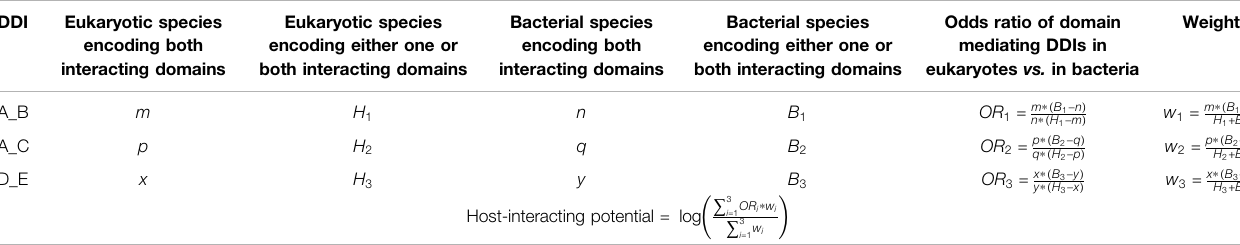
TABLE 2 | Weighted average host-interacting potential of a multi-domain bacterial protein. DDI Eukaryotic species encoding